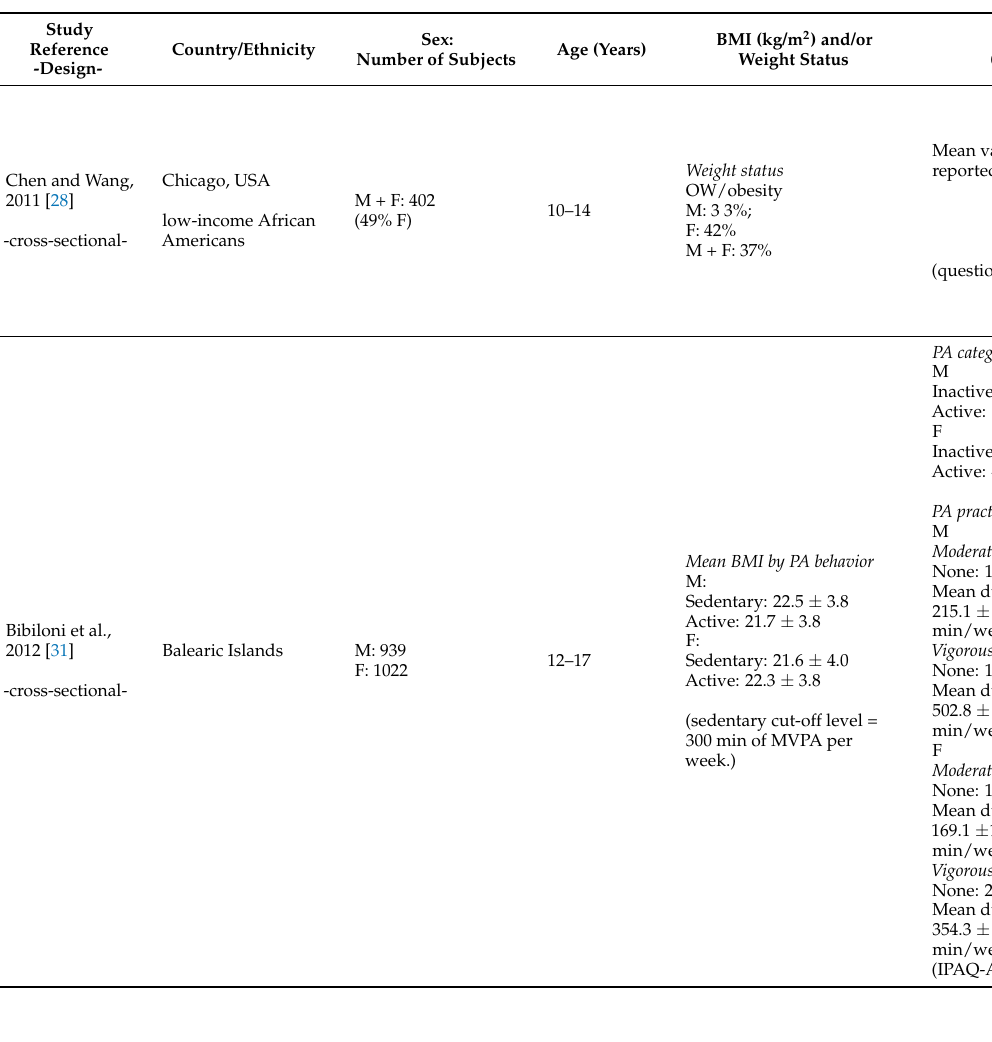
Table 2. Literature studies reported in chronological order on body image dissatisfaction, PA, anthropometric profile in adolescents.